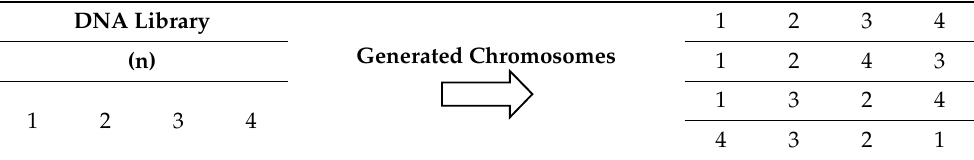
Figure 2. Process routes in the flow shop system with four tasks. Table 2. Genetic material in the DNA library for four tasks. DNA Library Generated Chromosomes